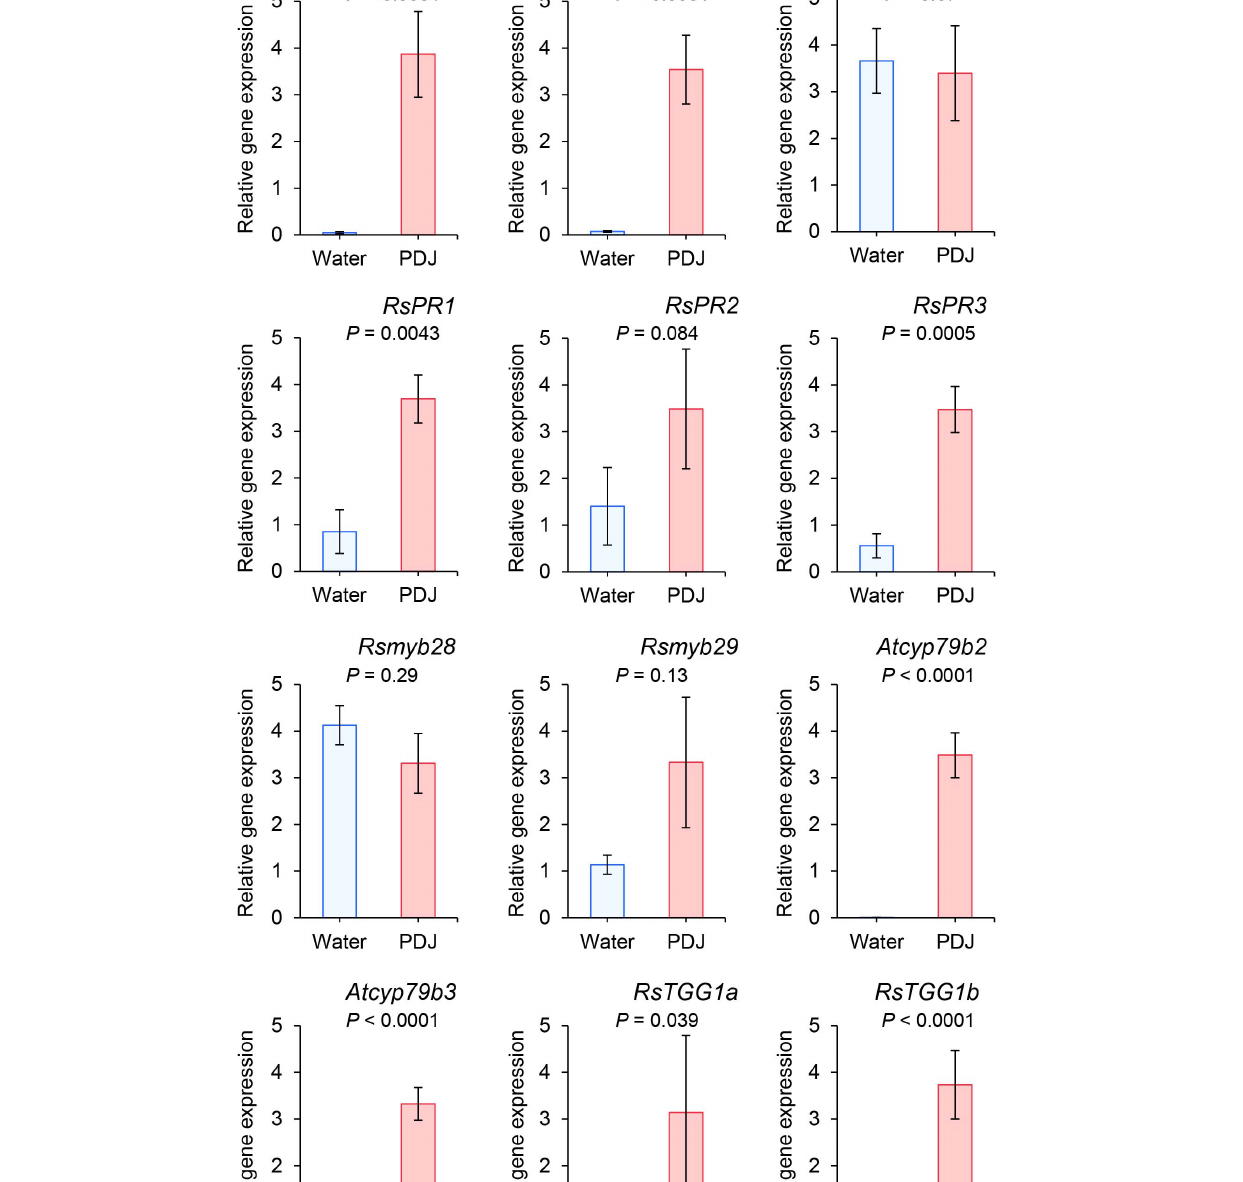
We also observed the effects of the PDJ treatments on the expression of the genes related to glucosinolate